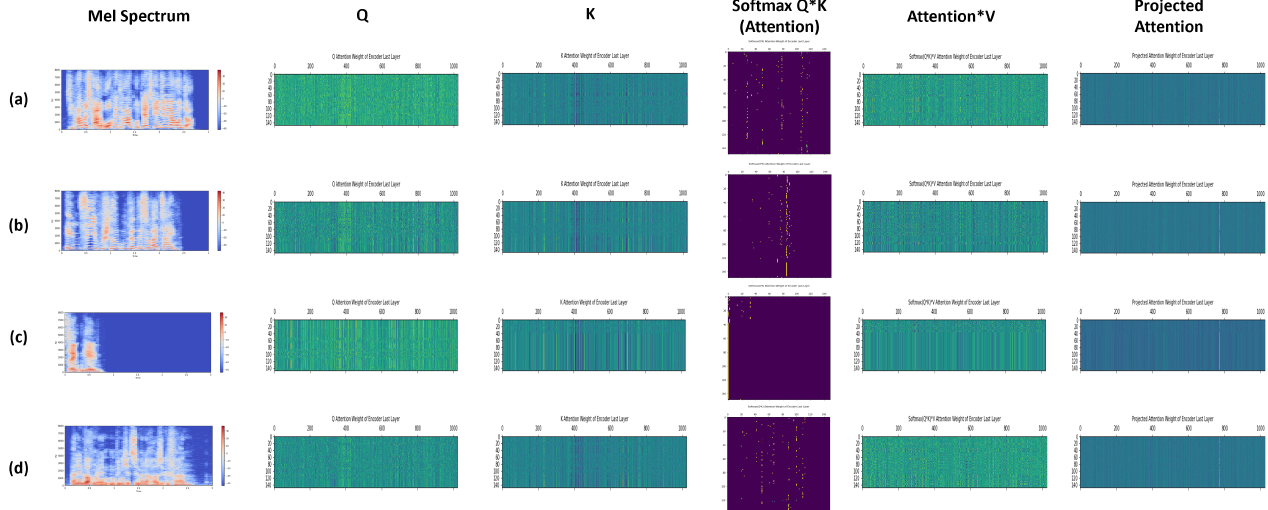
Figure 4. Attention weights of last layer encoded feature using fine-training of XLSR based on the Emo-DB dataset: ( a ) normal speech chunk, ( b ) chunk containing normal silence, ( c ) chunk containing mostly silence, and ( d ) chunk between speech. Please see the full resolution image in the supplementary